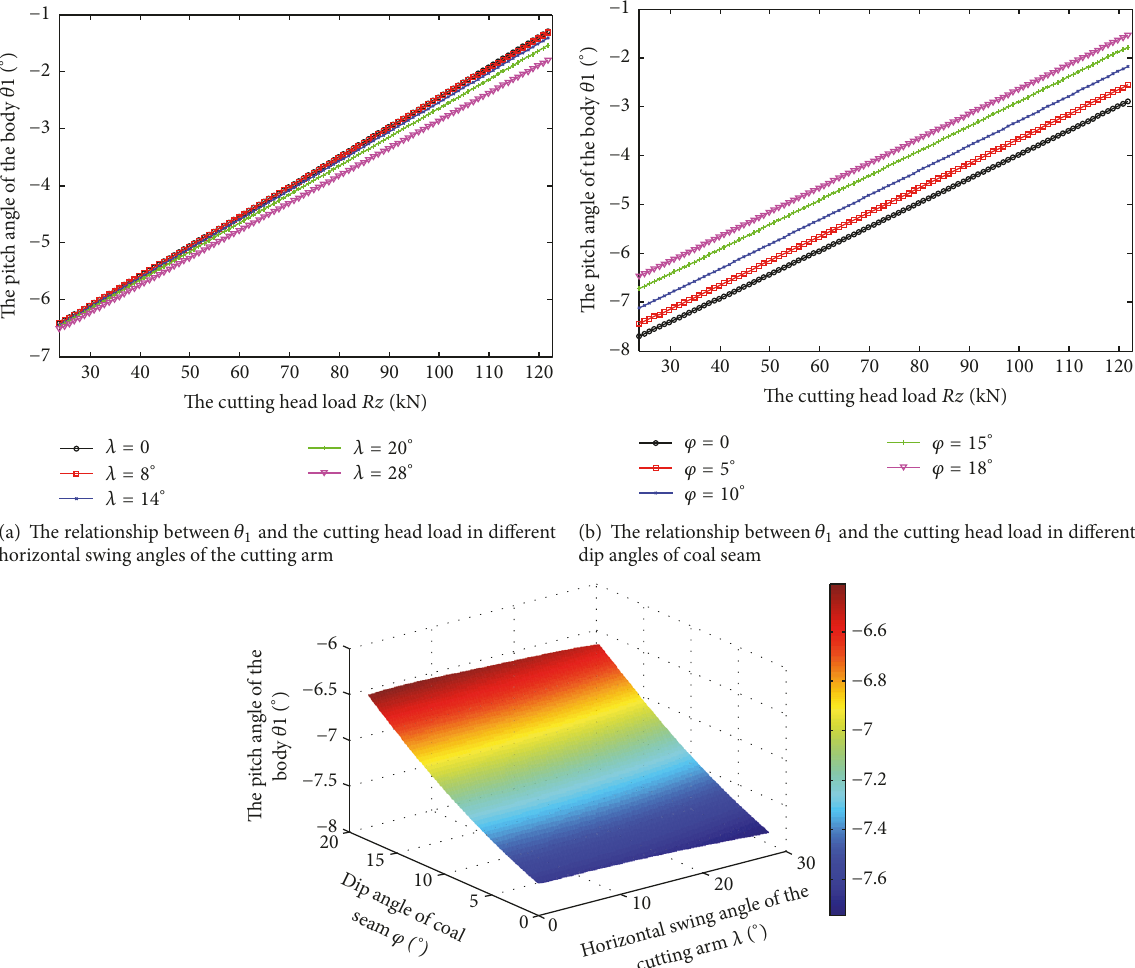
(c) The relationship of 𝜃 1 , horizontal swing angle of the cutting arm and the dip angle of coal seam Figure 14: The response results of the pitch angle of the body 𝜃 1